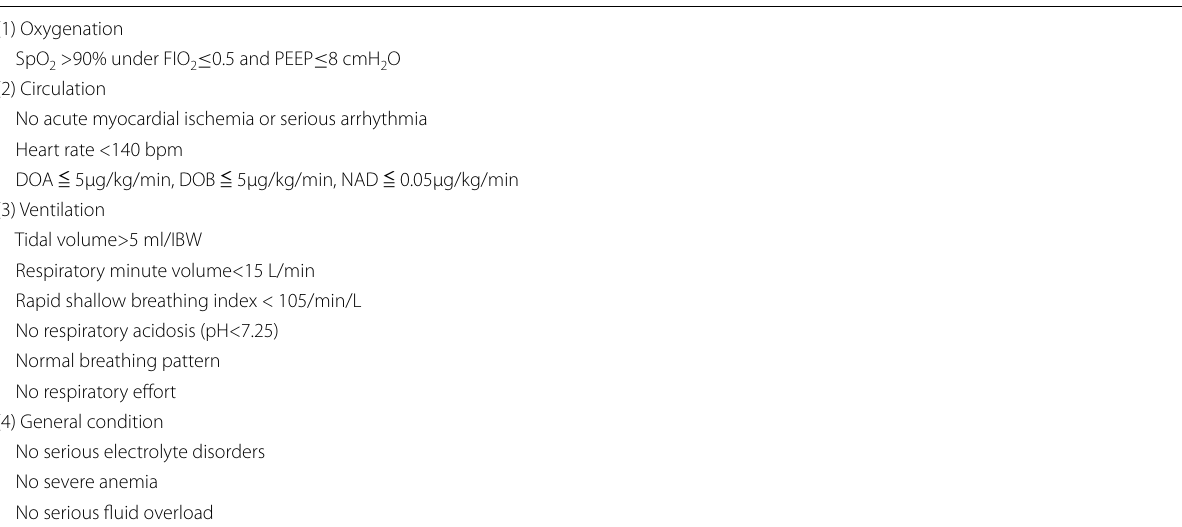
Table 1 Criteria for initiating SBT